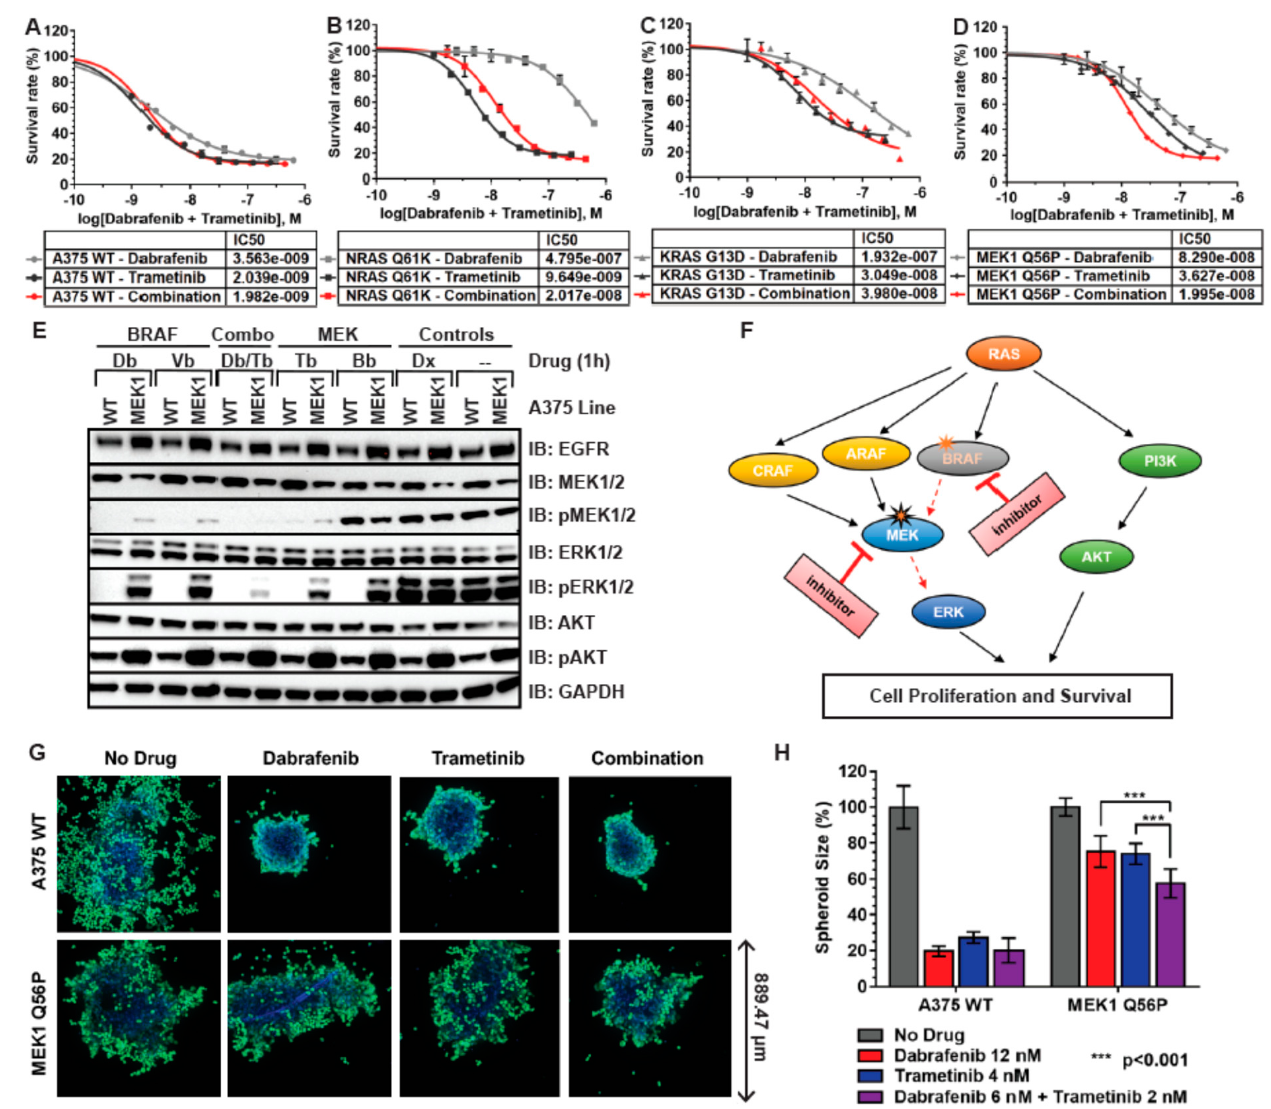
Figure 5. MEK1 Q56P melanoma model is sensitive to combination BRAF/MEK inhibitor treatment in both 2D and 3D tissue culture. ( A ) Dose-response curves for A375 WT cells in 2D tissue culture with dabrafenib (grey line), trametinib (black line), or a combination of dabrafenib and trametinib (red line, molarity indicates total drug concentration); ( B ) Dose-response curves for NRAS Q61K cells in 2D tissue culture with dabrafenib, trametinib, or a combination of dabrafenib and trametinib; ( C ) Dose-response curves for MEK1 Q56P cells in 2D tissue culture with dabrafenib, trametinib, or combination; ( D ) Dose-response curves for MEK1 Q56P cells in 2D tissue culture with dabrafenib, trametinib, or combination. Lower survival with combination indicates synergistic drug killing in this line; ( E ) Immunoblot demonstrating synergistic inhibition of the MEK/ERK signaling pathway in MEK1 Q56P melanoma model cells in 2D tissue culture. Cells were treated with either 1.0 μ M of the indicated inhibitor compound or with 0.5 μ M each of each indicated drug for 90 min prior to harvesting protein (Db = dabrafenib 1.0 μ M, Vb = vemurafenib 1.0 μ M, Tb = trametinib 1.0 μ M, Bb = binimetinib 1.0 μ M, Db/Tb = dabrafenib 0.5 μ M + trametinib 0.5 μ M); ( F ) Model of synergistic inhibition of the RAS/RAF/MEK/ERK pathway by combination MEK and BRAF inhibitor treatment. Orange star indicates the primary BRAF V600E mutation which drives cell proliferation in the ab- sence of BRAF inhibitor. Treatment with BRAF inhibitor results in secondary MEK1 Q65P mutation (black outlined orange star). In the presence of these two mutations, upstream pathway inhibition with BRAF inhibitor in combination with downstream pathway inhibition with MEK inhibitor (red arrows) leads to less cell survival and proliferation than is observed when each drug is used alone; ( G ) Susceptibility of MEK1 Q56P cells grown in 3D tissue culture to dabrafenib, trametinib, and combination drug treatment. For each indicated cell type, 500 cells were seeded in each well of a